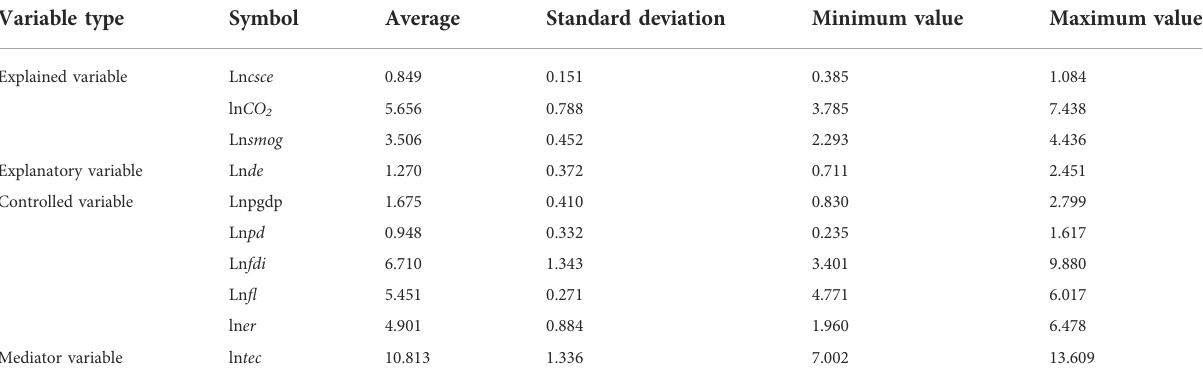
TABLE 1 Descriptive statistics of variables.